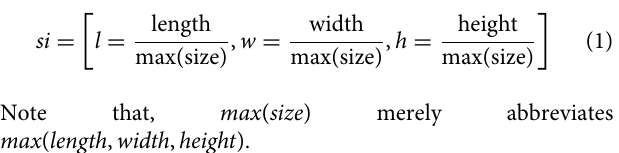
input. Consequently, these property values are originated from